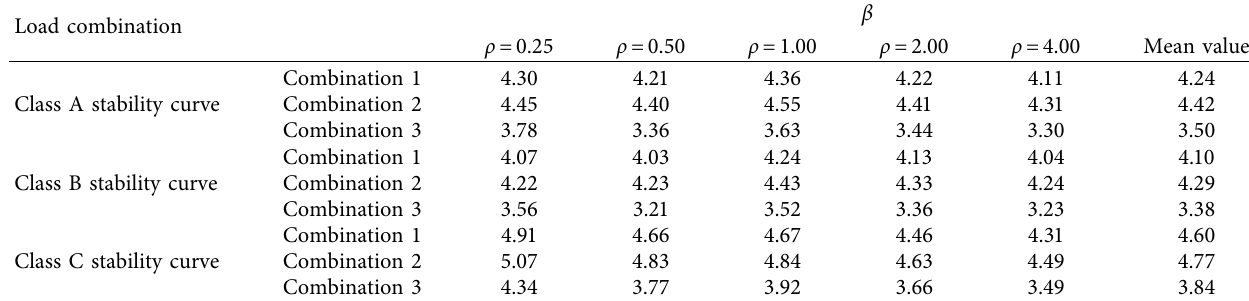
Table 8: Calculated results of the reliability index β